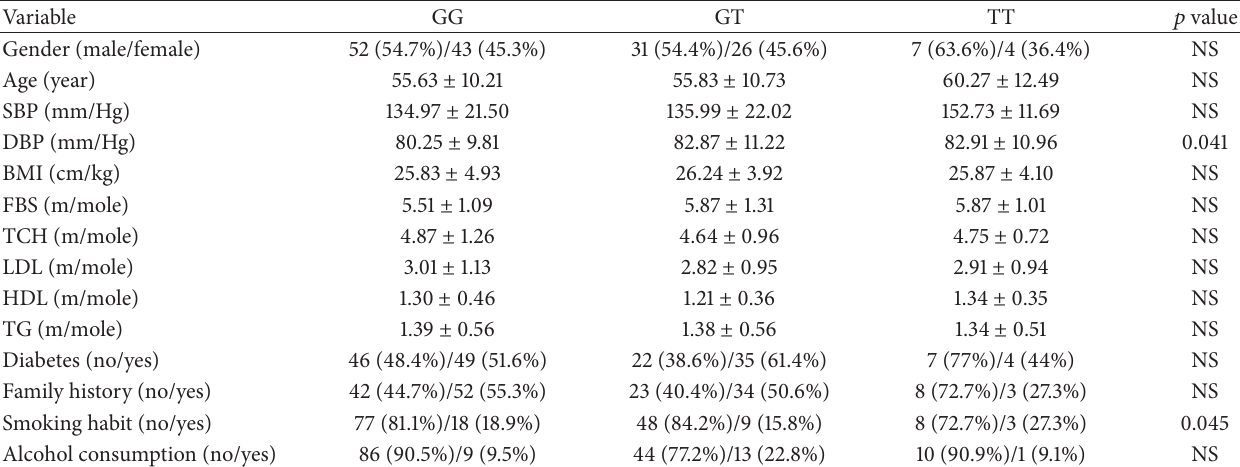
Table 3: Genotype-clinical characteristics correlations in patients.